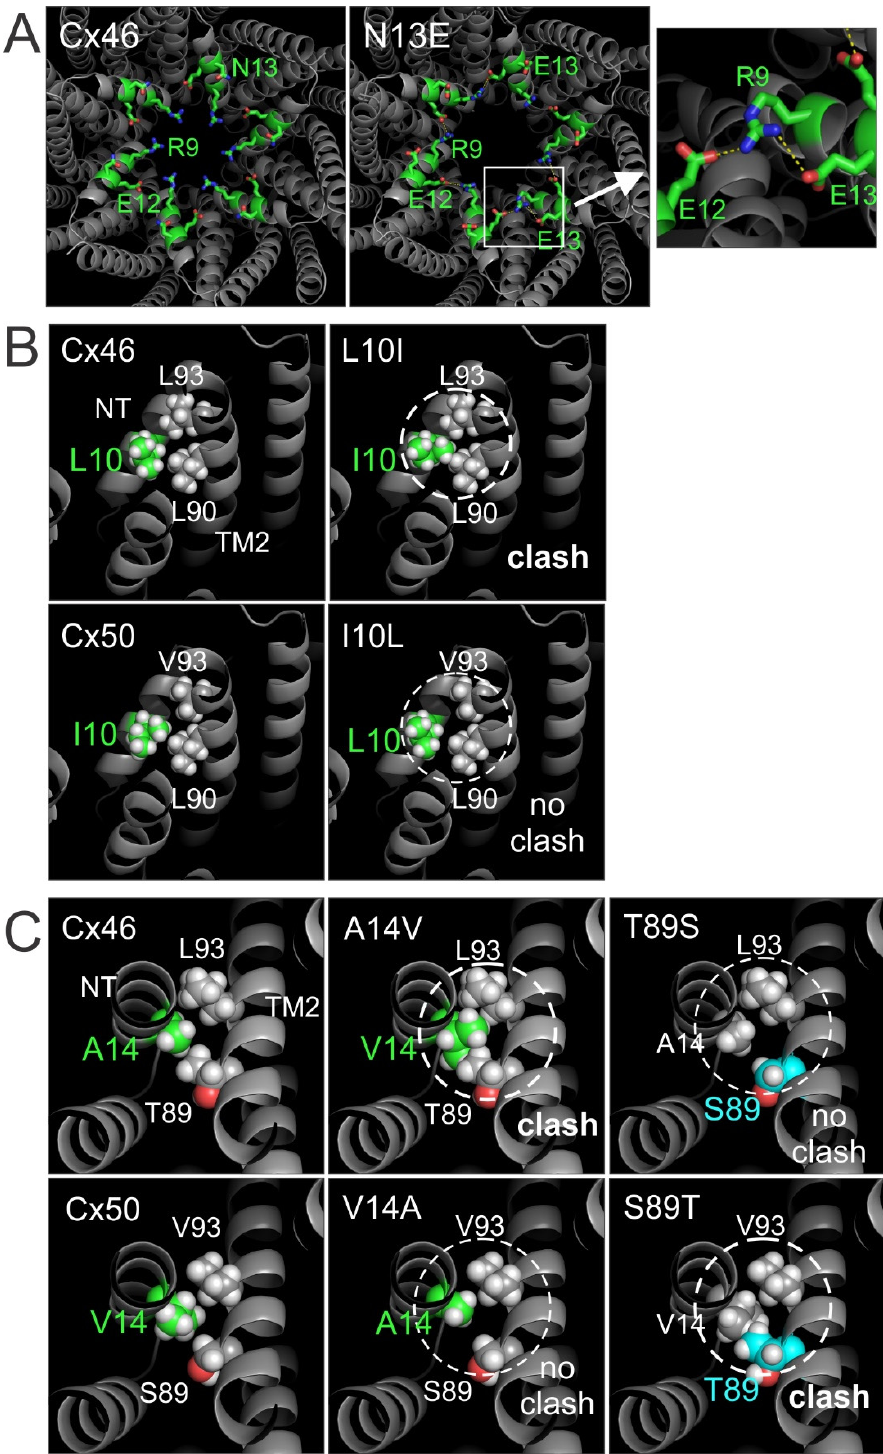
Figure 9. Structural models for selected variant GJs. ( A ) Cx46 GJ model determined by Cryo-EM (PDB: 7JKC) is shown on the left panel with a viewing angle facing the pore entrance. Homology model of Cx46 N13E is shown in the middle panel to show that R9 and E12 frequently interact with one another via salt-bridges. On one occasion, the side chain of E13 also interacts with the side chain of R9 of the same subunit to form a salt-bridge interaction (see enlarged view on the right panel. Note that R9 also formed a salt-bridge interaction with E12 of a neighboring subunit as shown). ( B ) Zoomed view of Cx46 and Cx50 highlighting the interactions of the 10th residue with 90th and 93rd residues on the TM2 domain (left panels). Cx46 L10I caused a steric clash between I10 and L90, while the Cx50 I10L did not lead to any steric clash with L90 or V93 (right panels). ( C ) Zoomed view of